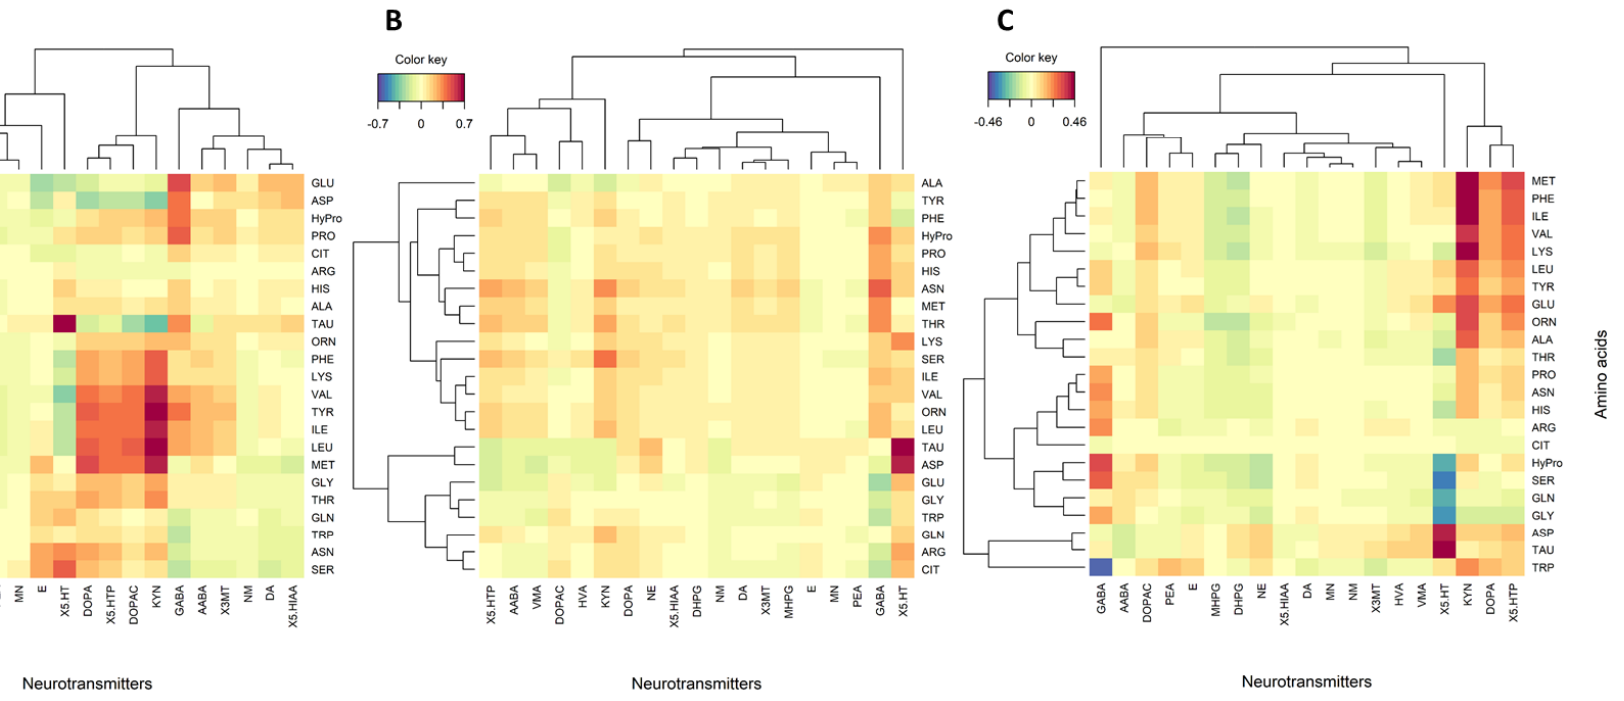
Figure 3. Clustered image maps (no cutoff) between plasma neurotransmitters and proteogenic and non-proteogenic amino acids for ( A ): healthy control, ( B ): constipation group (FC+IBS-C), and ( C ): diarrhea group (FD+IBS-D).